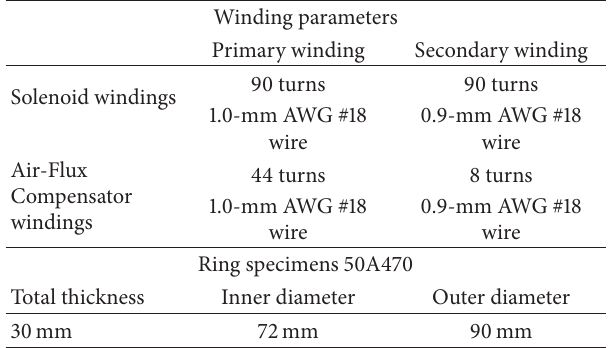
Table 1: Specifications for the new standardized toroidal frame with high